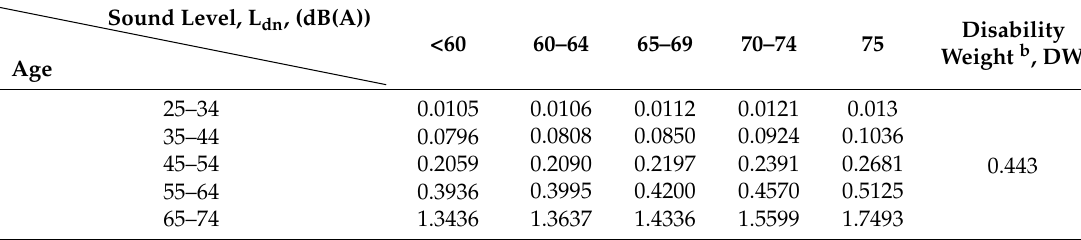
Table 1. Probability risk a of myocardial infarction caused by construction noise, in percent. Sound Level, L dn , (dB(A)) Age